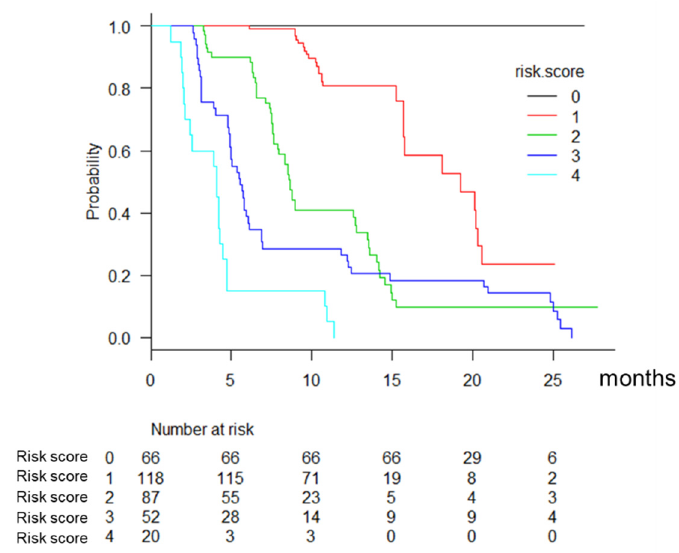
Figure 3. Overall survival according to the risk